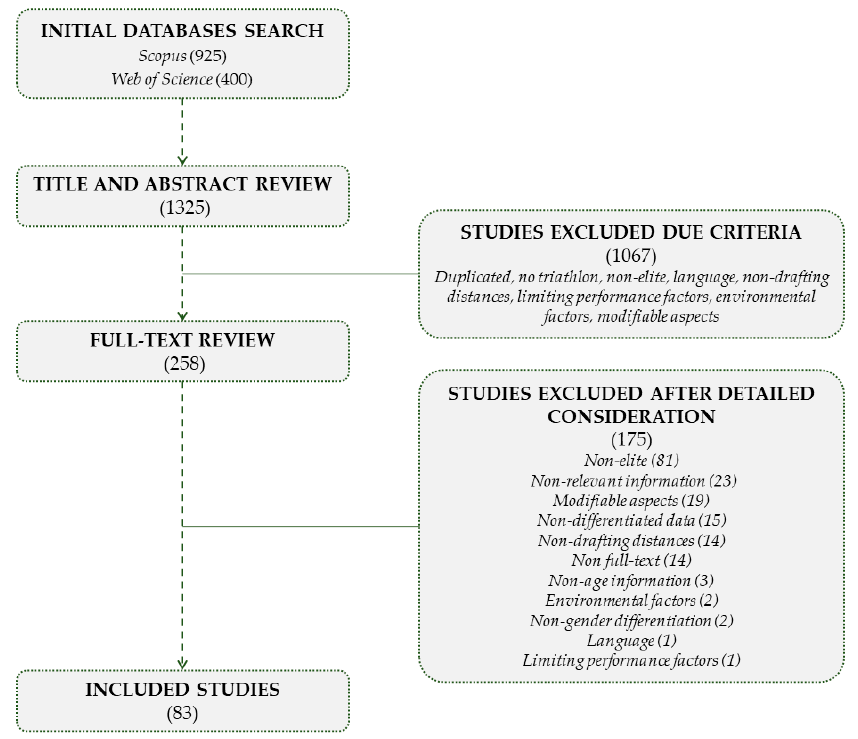
Figure 1. Flow chart for study selection.